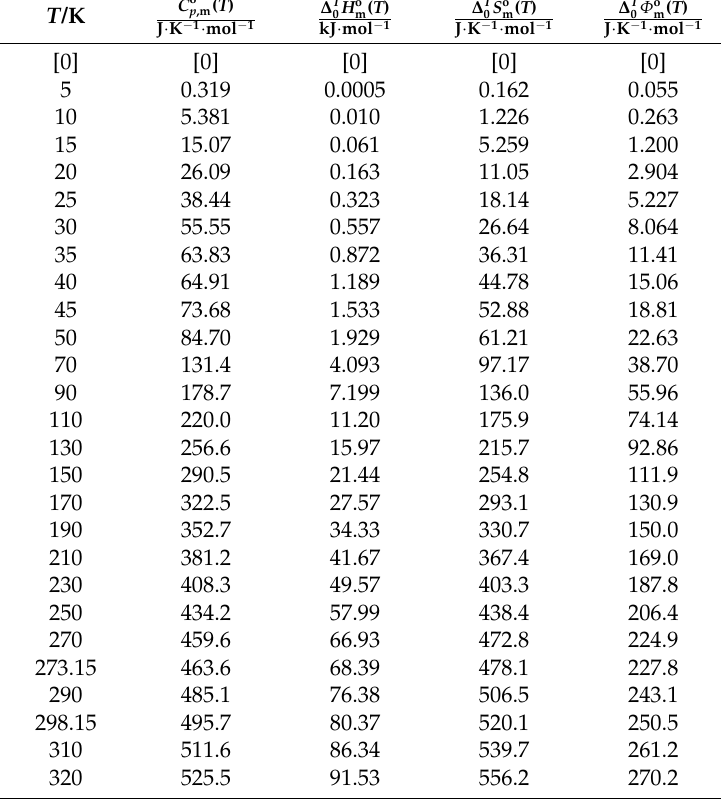
Table 5. Standard molar thermodynamic functions of mandarinoite(cr) at p = 0.1 MPa a